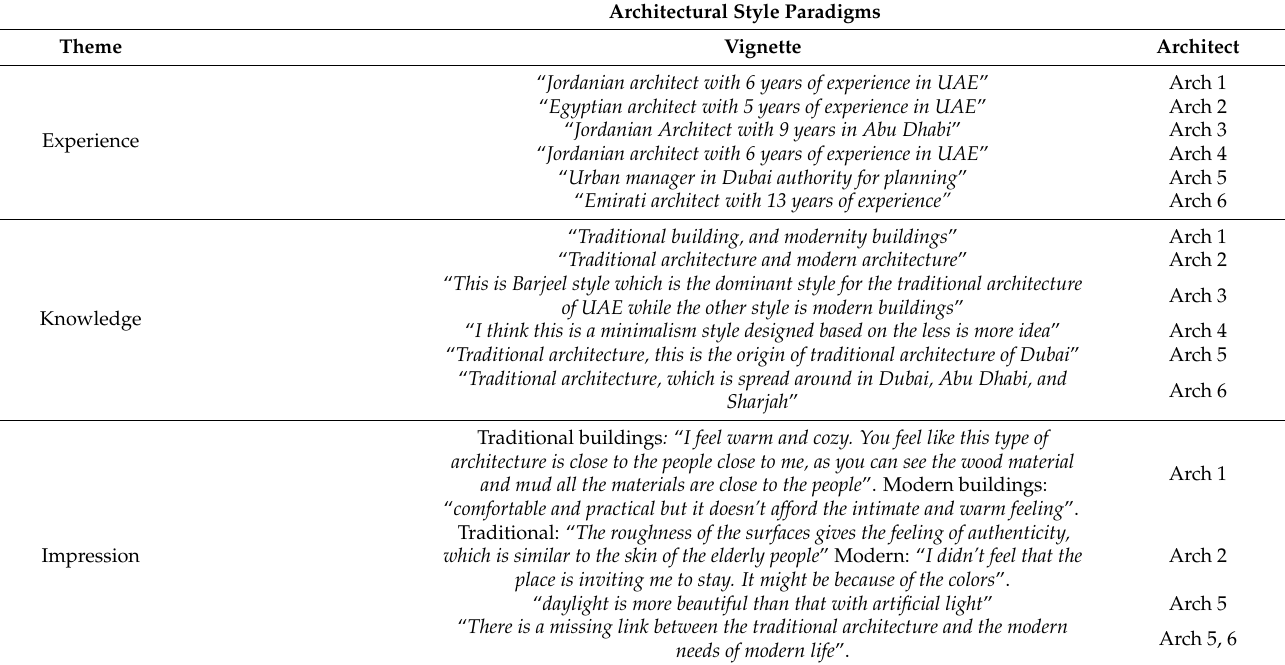
Table 7. Summary of the architect